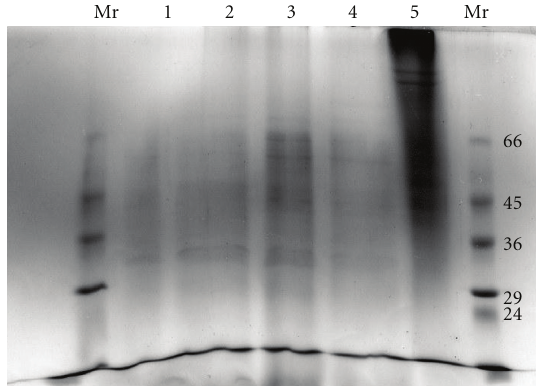
Figure 4: Polyacrylamide gel electrophoresis (PAGE) analysis of saiga horns protein. Left lane: low Mr markers: Albumin, bovine serum (Mr 66,000), Ovalbumin, chicken egg (Mr 45,000), Glycer- aldehyde-3-phosphate dehydrogenase, rabbit muscle (Mr 36,000), Carbonic anhydrase, bovine erythrocytes (Mr 29,000), Trypsino- gen, bovine pancreas (Mr 24,000), Trypsin Inhibitor, soybean (Mr 20,000), α -Lactalbumin (Mr 14,200), Aprotinin, bovine lung (Mr 6,500); (lane 1) 1.7 PGV; (lane 2) 1.7 DGV; (lane 3) 3 DGN; (lane 4) 3DGV; (lane 5) collagen type I; and right lane: low Mr